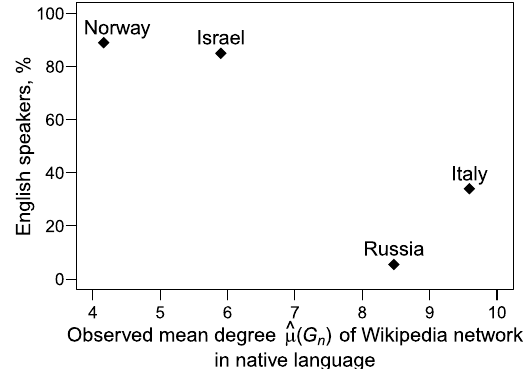
Figure 5. Estimated mean degrees of the Wikipedia networks in Hebrew, Italian, Norwegian, and Russian vs. percent of people in corresponding countries who can speak